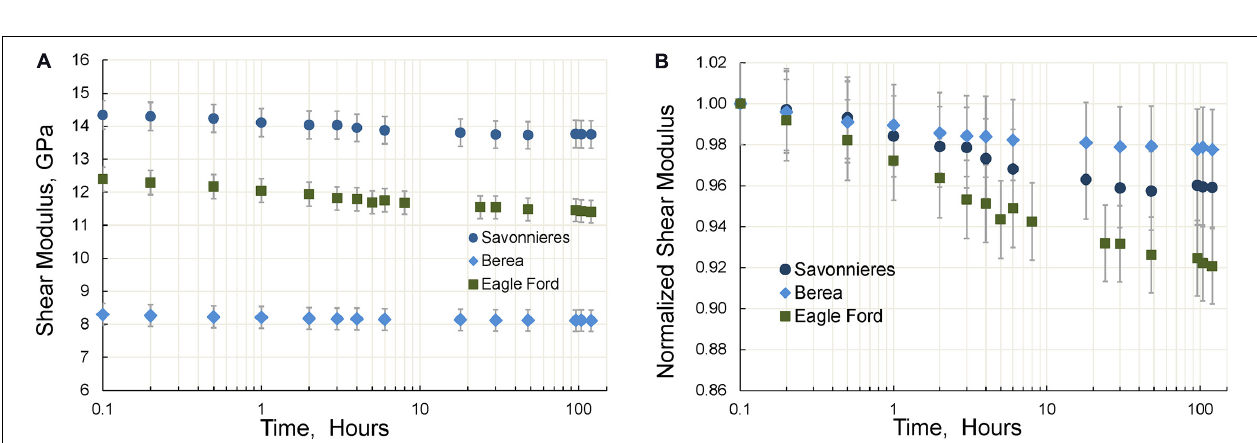
Frontiers in Earth Science |